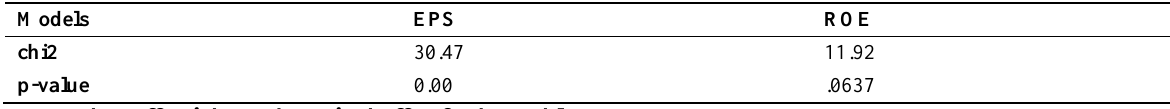
Table 5: Summary of the output of the Hausman Test